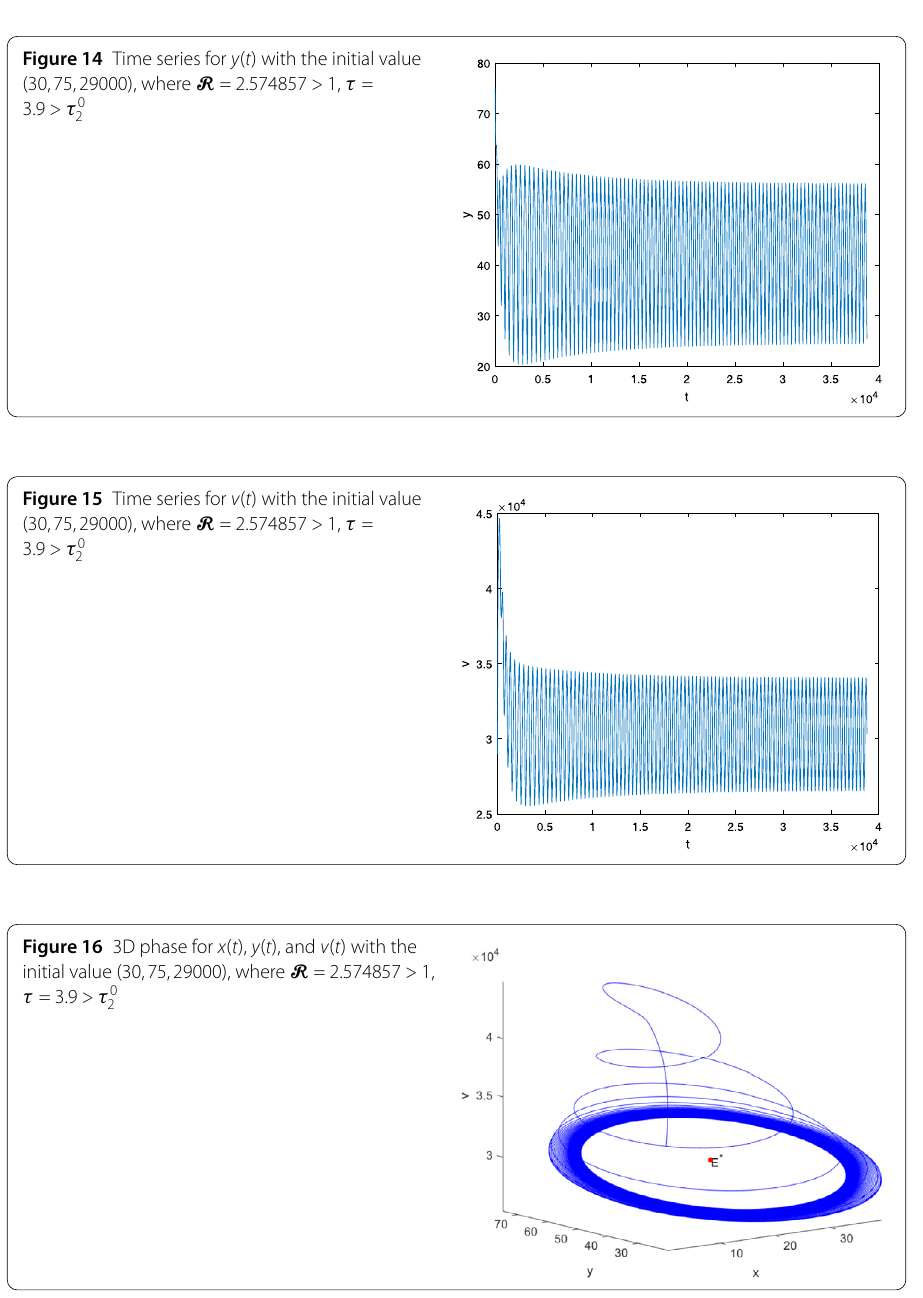
Figure 14 Time series for y ( t ) with the initial value (30,75,29000), where R = 2.574857 > 1, τ =